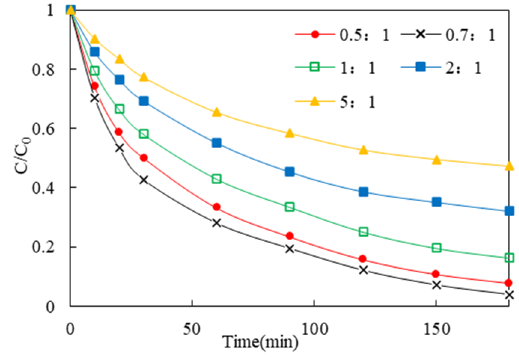
Figure 4. Influence of various Fe 3 O 4 and α -MnO 2 molar ratios on the degradation of